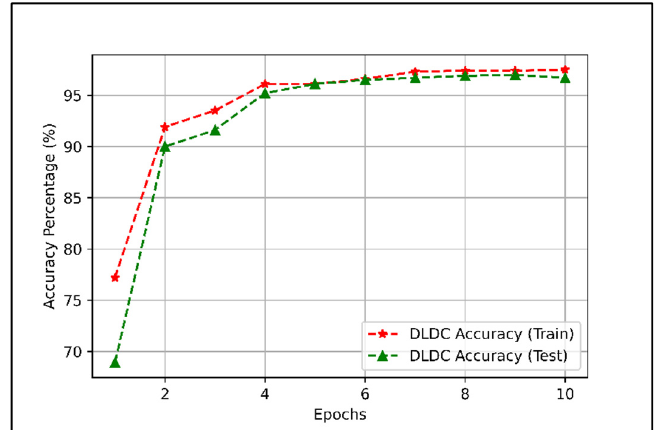
Figure 6. DLDC model training as well as testing accuracy for 10 training epochs.